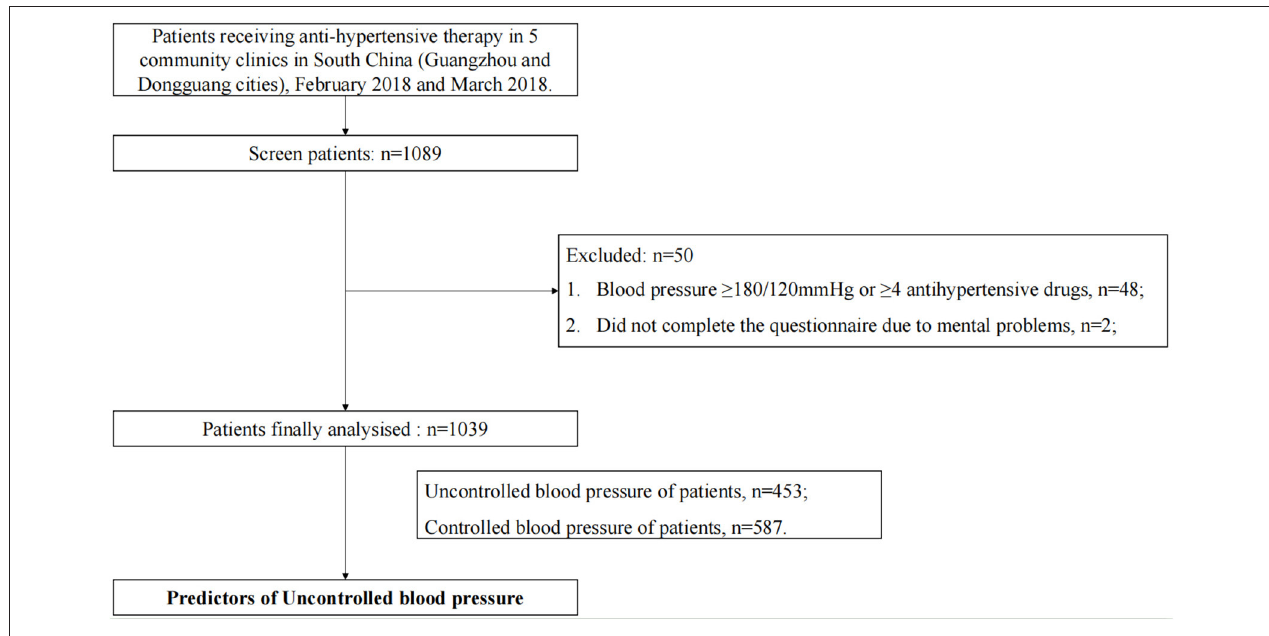
FIGURE 1 | Study flow.